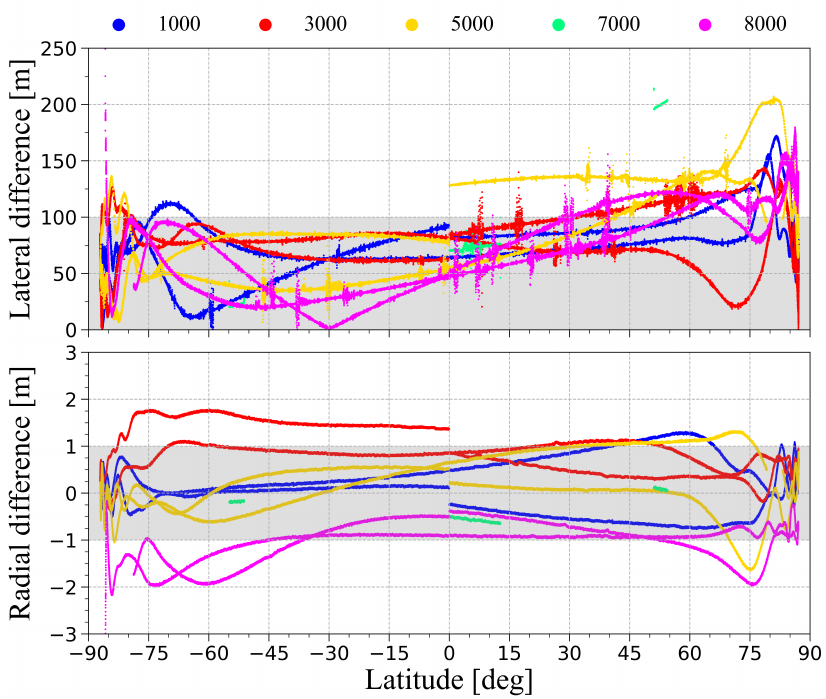
Figure 6. Lateral ( top ) and radial ( bottom ) differences of PAM with Mars as the observer using up- dated auxiliary information with respect to cross-over-corrected PEDR for the selected nadir profiles. Shaded areas denote the inherited uncertainties in the PEDR cross-over-corrected locations